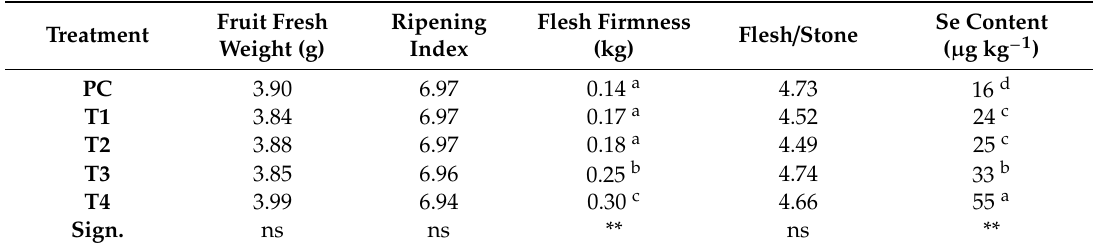
Table 5. Physical characteristics of olive fruits cv. “Carolea” at harvest after plant selenate spraying (none, one, two, three and four times respectively for PC, T1, T2, T3, T4). Fruit fresh Ripening Flesh firmness Se content Treatment Flesh/stone weight (g) index (kg) (µg kg − 1 ) PC 3.90 6.97 0.14 a 4.73 16 d T1 3.84 6.97 0.17 a 4.52 24 c T2 3.88 6.97 0.18 a 4.49 25 c T3 3.85 6.96 0.25 b 4.74 33 b T4 3.99 6.94 0.30 c 4.66 55 a Sign. ns ns ** ns ** The data are presented as means. ** Significance at p < 0.01; n.s. not significant; Lowercase letters show differences by Tukey’s multiple range test .